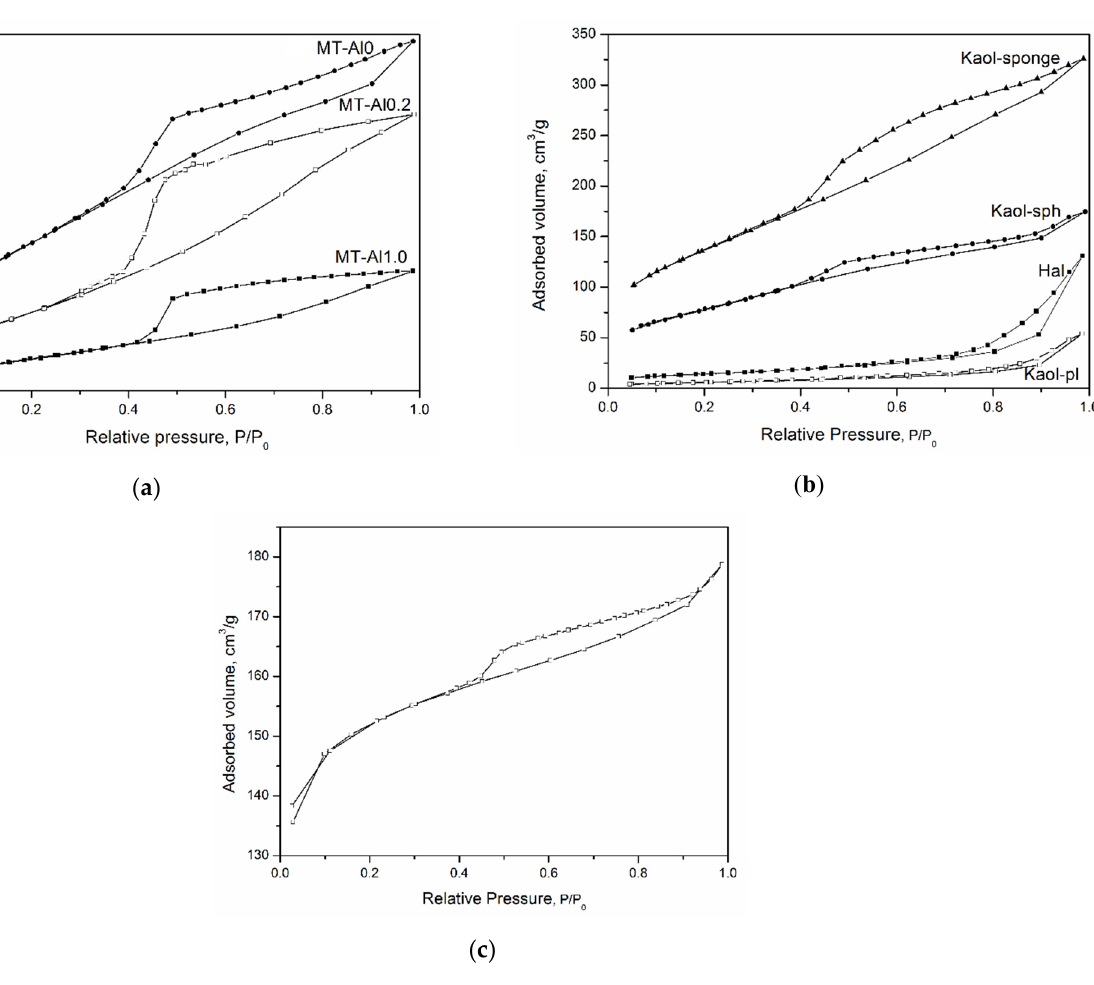
Figure 3. N 2 adsorption–desorption isotherms of the samples: ( a )—aluminosilicates with montmorillonite structure; ( b )—aluminosilicates with kaolinite structure; and ( c )—zeolite Beta. Table 2. Properties of the studied samples of aluminosilicates.